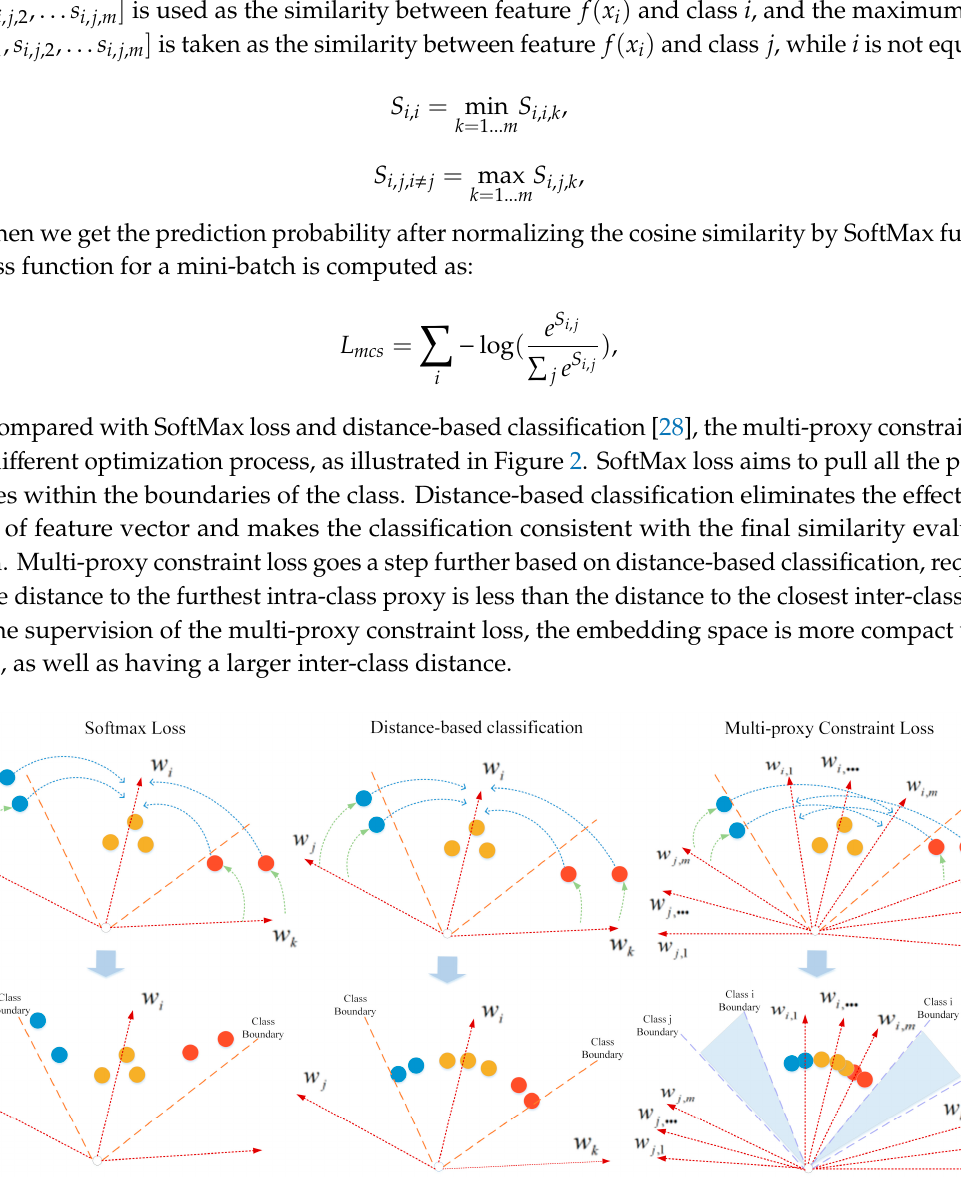
Figure 2. The comparison of optimization process supervised by SoftMax loss, distance-based classification, and multi-proxy constraint loss. The blue arc means the samples are pull closer to the weight vector of the corresponding class, and the green arc shows the samples are push away from the weight vector of the neighboring class. It can be seen that the multi-proxy constraint loss will generate a margin between adjacent classes.